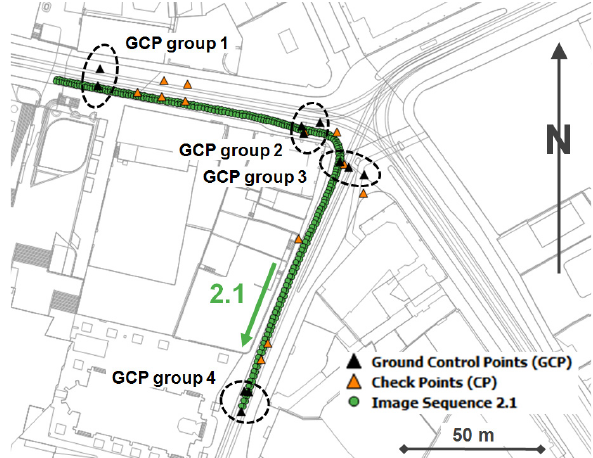
Figure 17. Locations of ground control point groups as well as check points for stereo image sequence